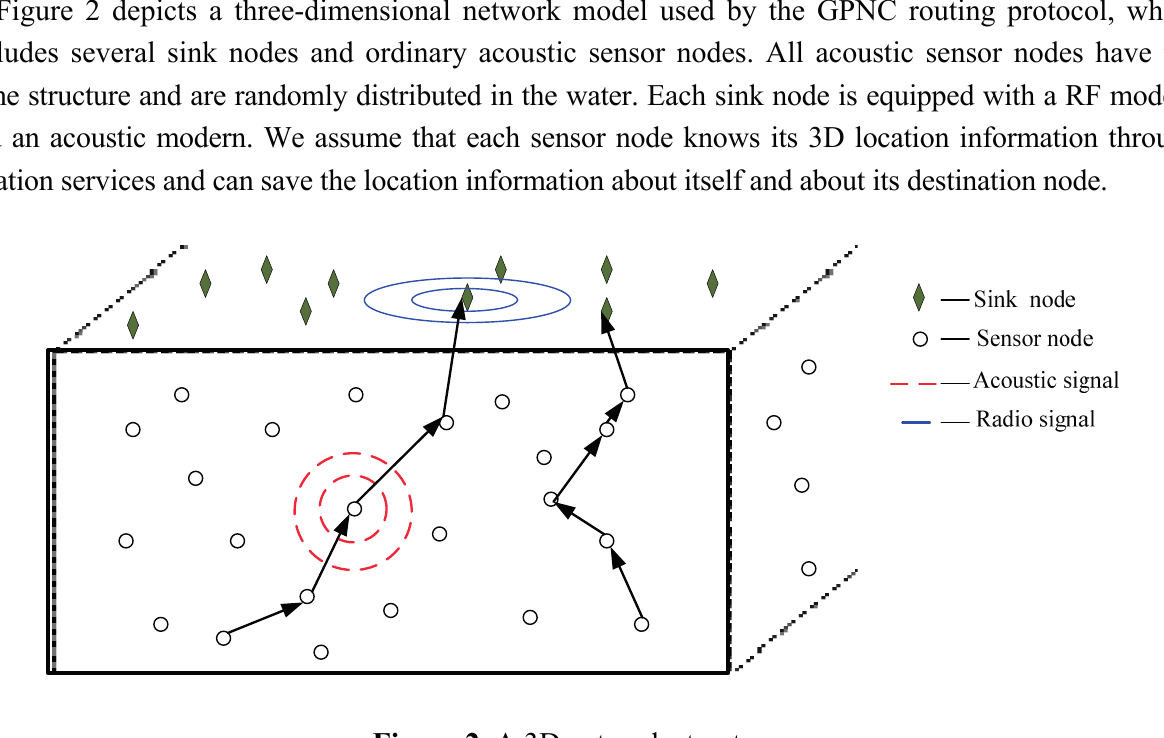
Figure 2. A 3D network